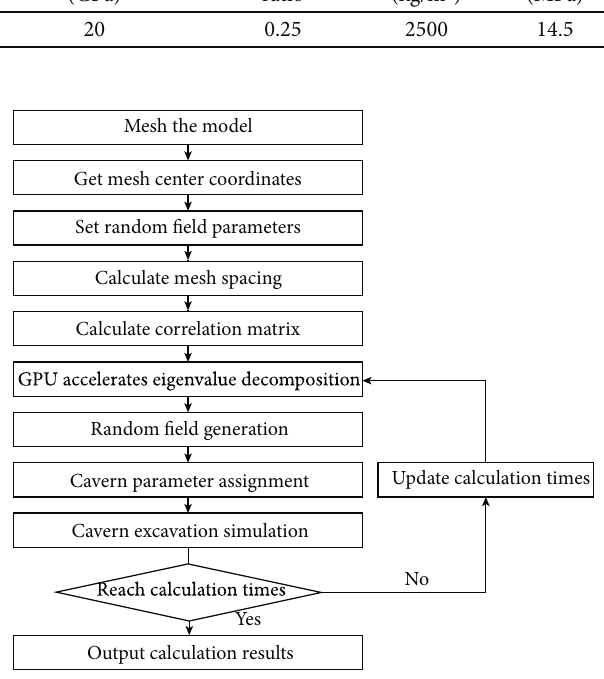
Figure 7: Meshed model and local enlarged fi gure of water diversion tunnel excavation simulation. Table 2: Suggested values of random fi eld parameters for red layer excavation tunnels in central Yunnan. Threshold of correlation function